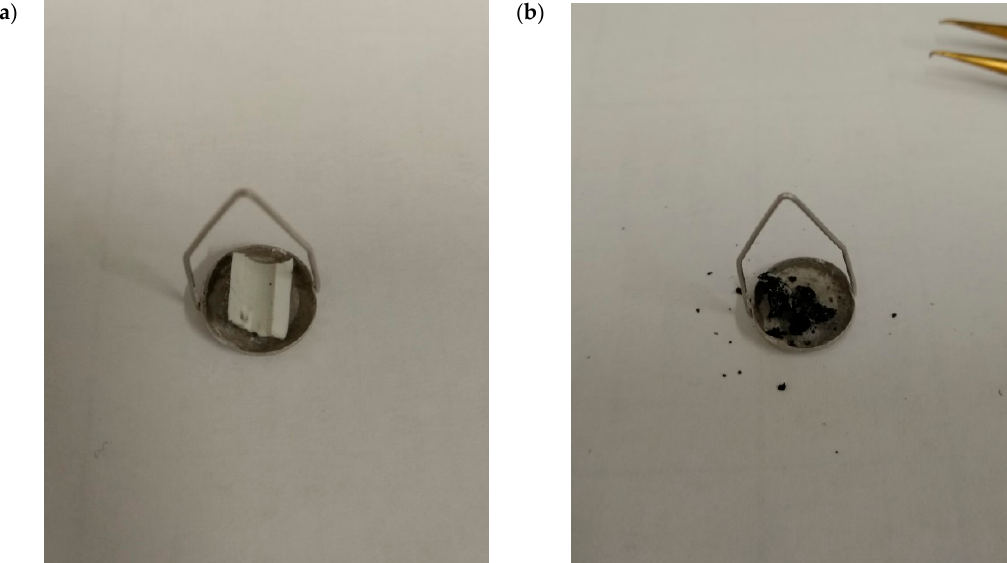
Figure 16. Outer sheath of a PVC coaxial cable placed in the TGA test platinum pan: ( a ) before the test, ( b ) after the